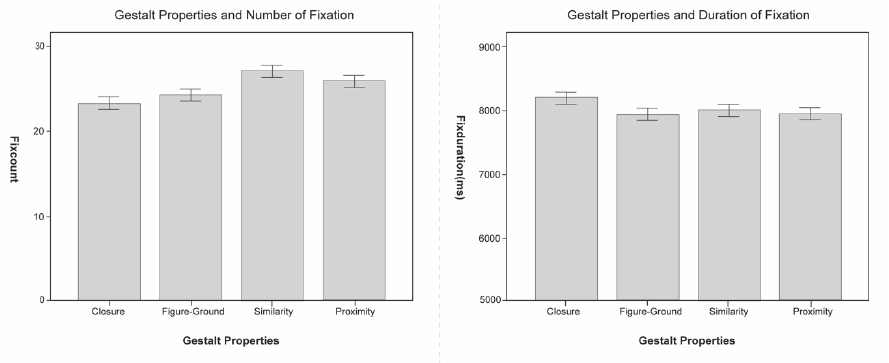
Figure 6. The Number of fixation and fixation durations of different gestalt